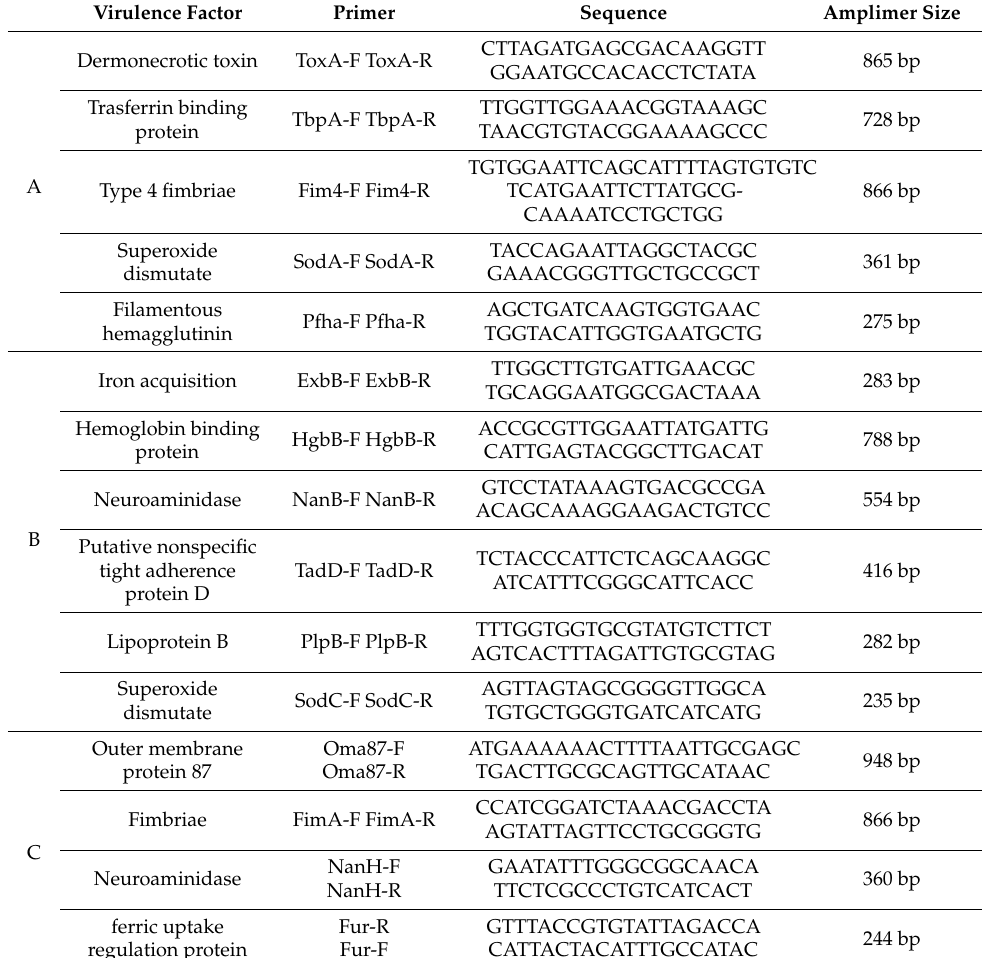
Table 2. A, B, and C protocols of Multiplex-PCR: investigated virulence genes, corresponding primers and nucleotide sequences, and molecular weights of